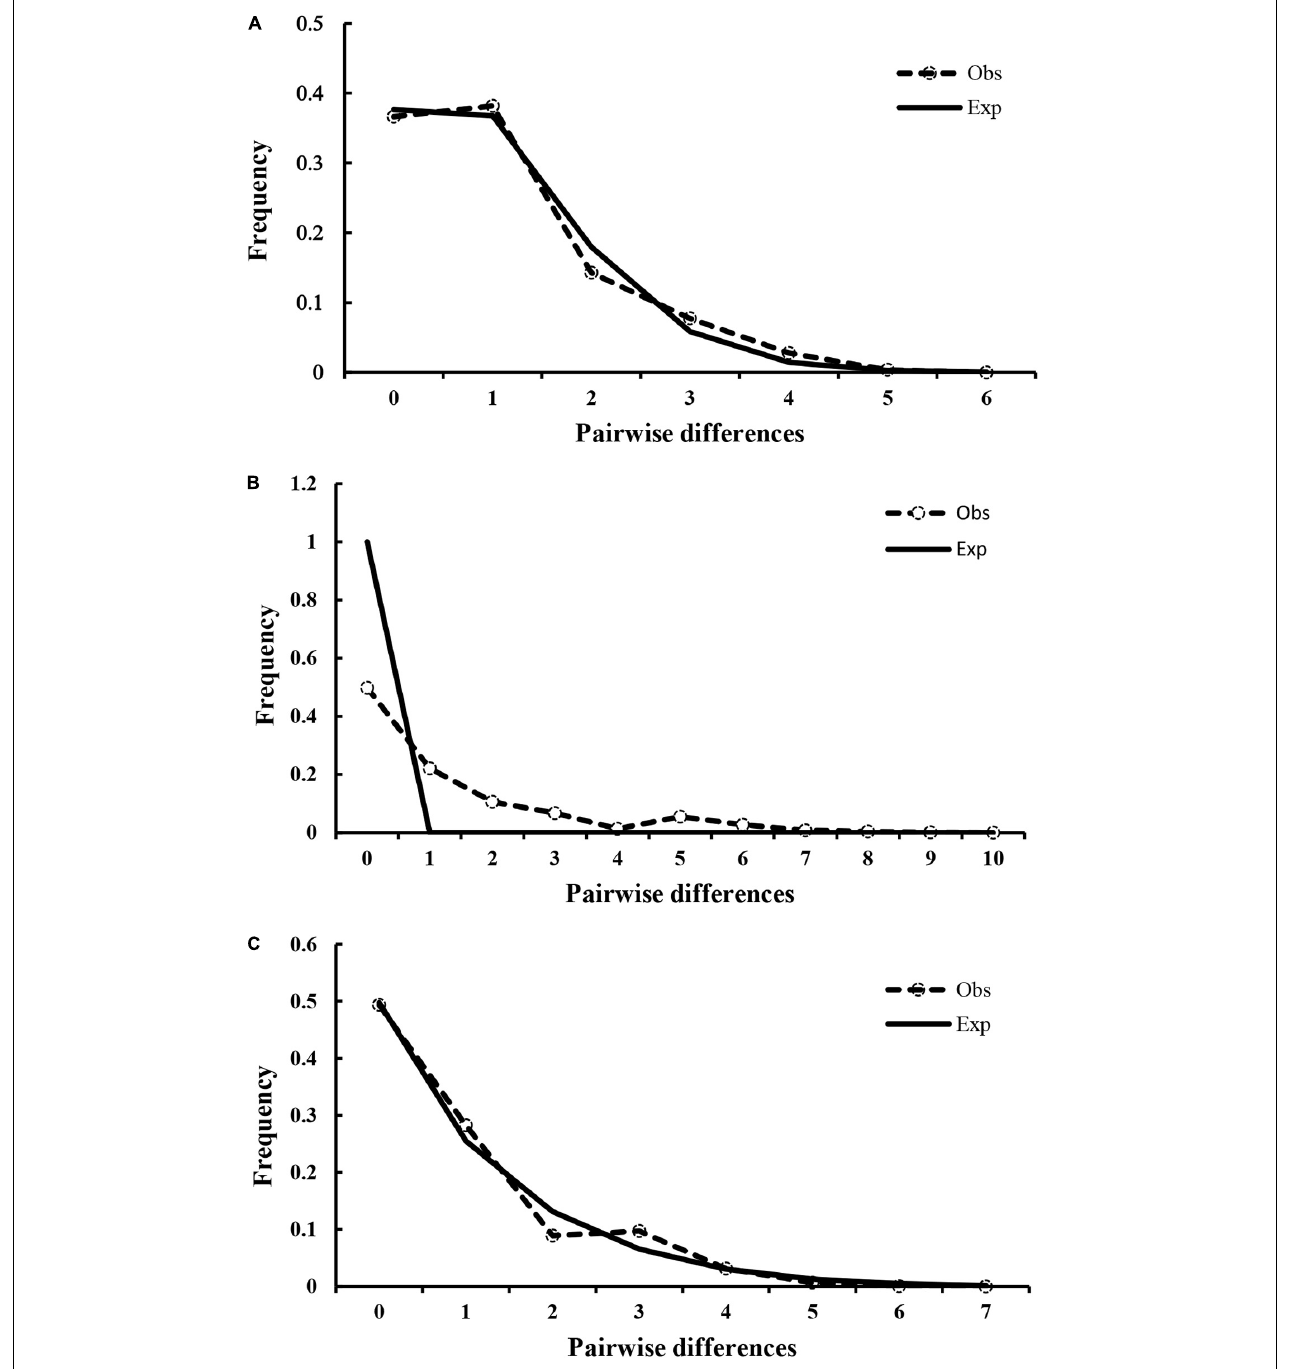
FIGURE 6 | Observed pairwise differences and expected mismatch distribution. Observed pairwise differences (dotted line with circles) and expected mismatch distribution (solid line) under the sudden expansion model for (A) A. lischkeana , (B) A. pectinata, and (C) Atrina sp.